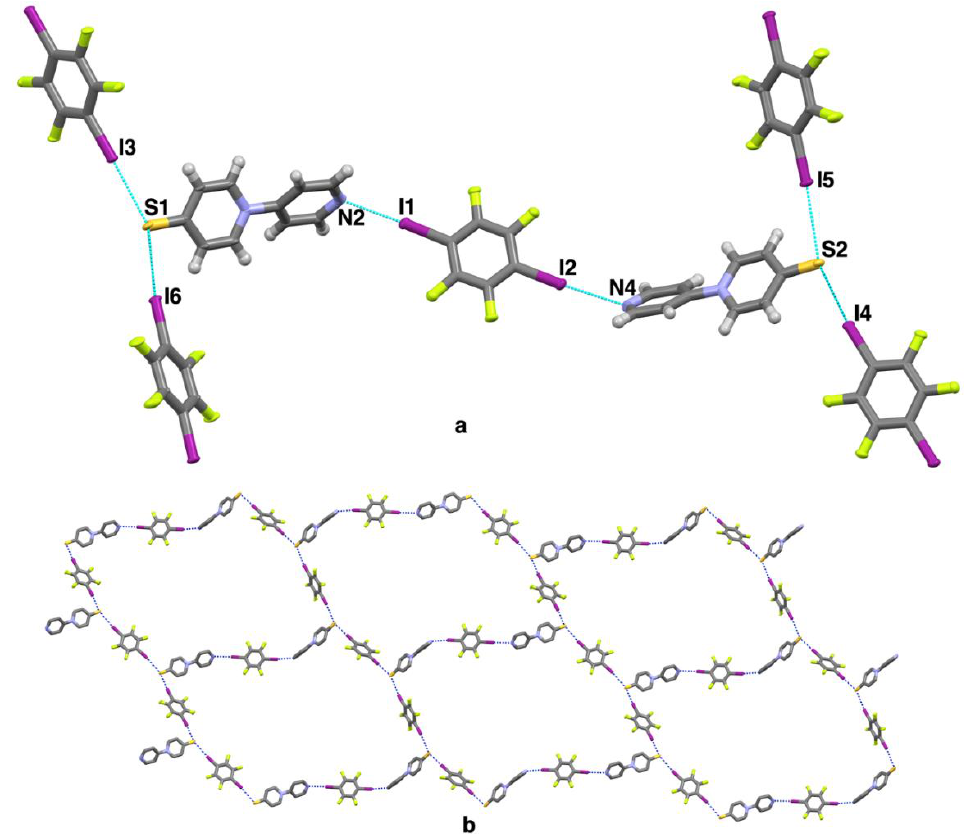
Figure 3a. Noticeably, two PTP molecules are connected via S1 … H-C [d S1…C 2.929Å , < S1…H-C 162.89  ] and I4 simultaneously connects a neighboring PTP molecule via I4 … H3-C3 [d I4…C3 3.927Å , < I4…H3-C3 136.98  ]. The key feature of this structure is that through the I … N and the bifurcated I … S XBs twelve membered rings are formed, giving an expanded wavy 2D network structure with S as the node (Figure 3). Furthermore, 2D networks are connected with adjacent units via F … H, F … C and S … H intermolecular contacts to form a five-folded interpenetrated 3D network. No solvent occupied channels edged by PTP/DITFB are formed.